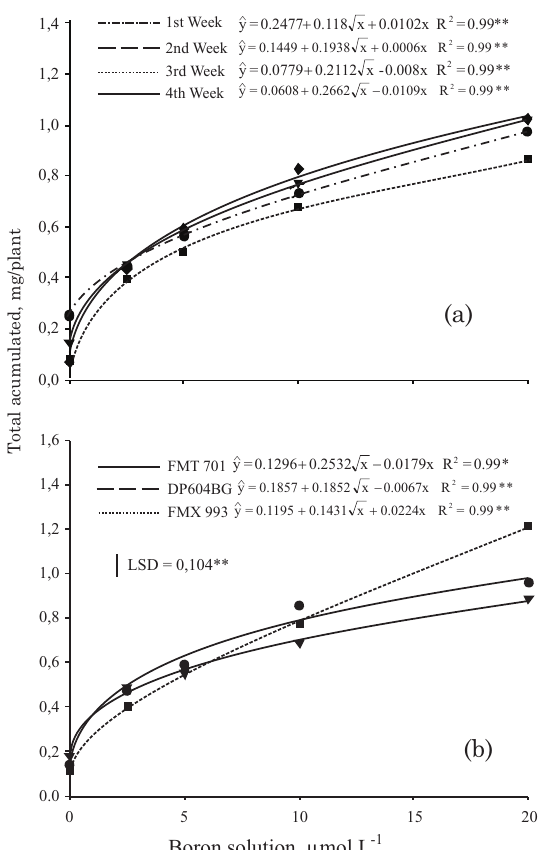
Figure 3. Total boron accumulated in cotton, measured in each of four harvests at weekly intervals starting at B1 (a), and total B accumulated in plants of three cotton cultivars in the third week after B1 (b), as affected by B rates in the nutrient solution. LSD = Least Significant Difference; * and ** significant at 5 and 1 %, respectively. (cid:122)(cid:122)(cid:122)(cid:122)(cid:122) , , , = 1 st , 2 nd , 3 rd and 4 th week, respectively. (cid:122)(cid:122)(cid:122)(cid:122)(cid:122) , , = FMT 701, DP 604BG and FMX 993, respectively.